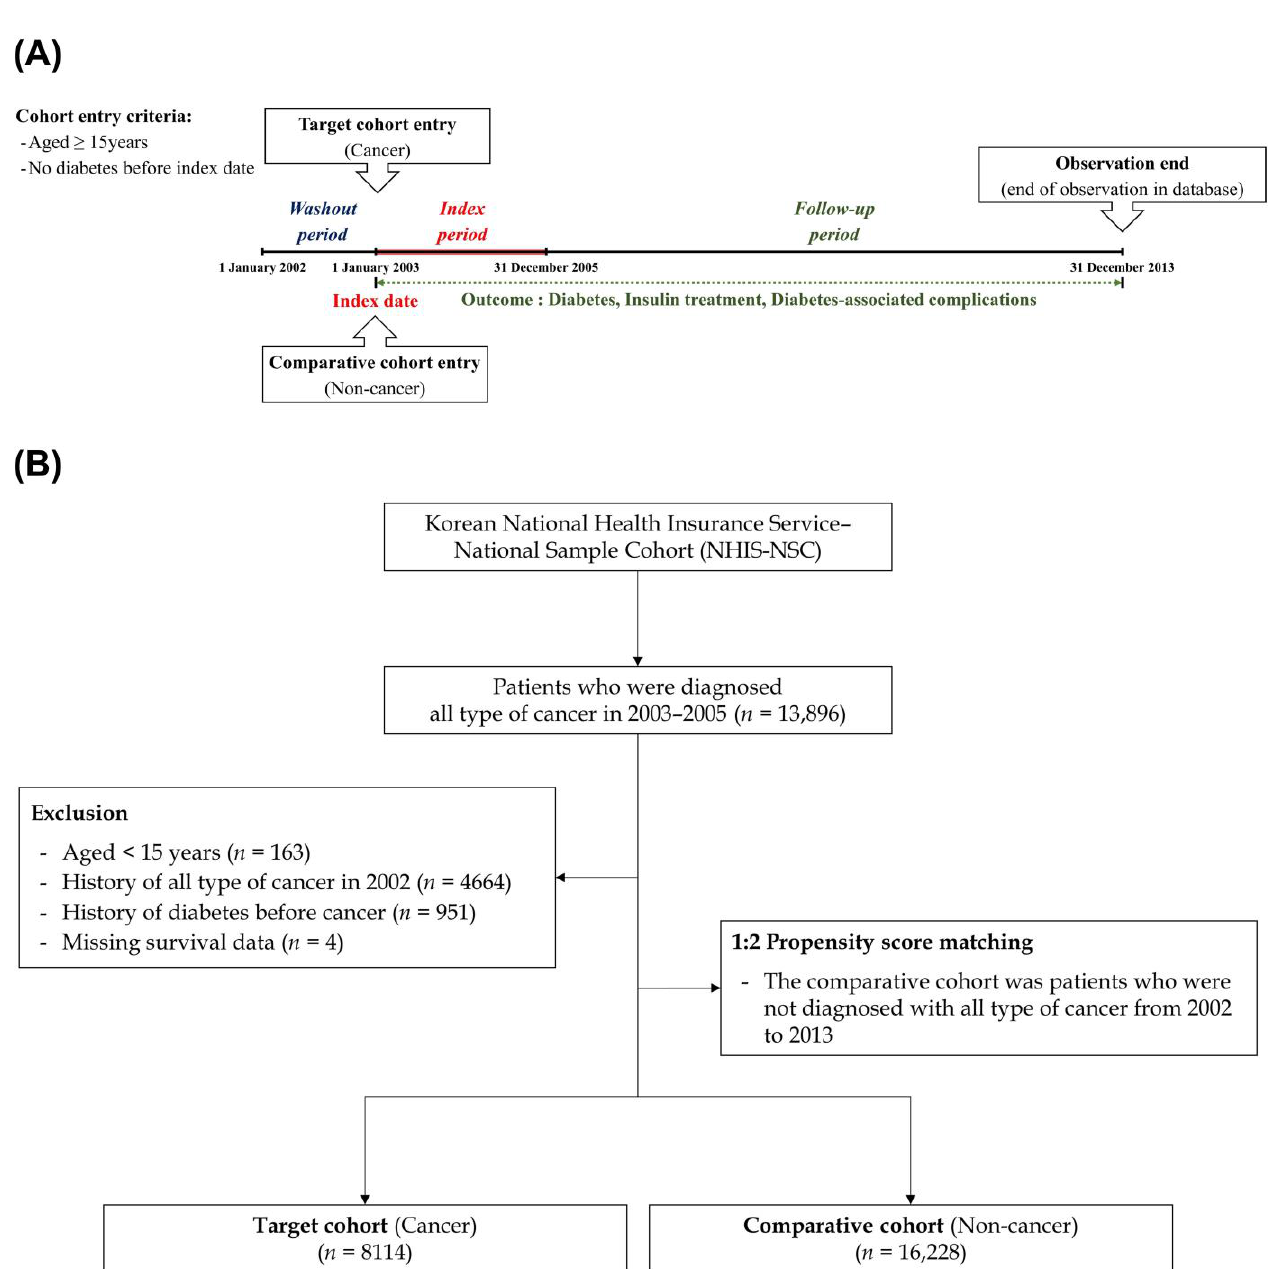
Figure 1. ( A ) Schematic description of the study design; ( B ) flow of enrollment of study participants. Briefly, we had a washout period of one year (January to December 2002) to exclude those with a risk of developing type 2 diabetes before cancer diagnosis. We then identified patients with cancer using the diagnostic codes during the index period (between January 2003 and December 2005). We defined the cancer group using the presence of the same C